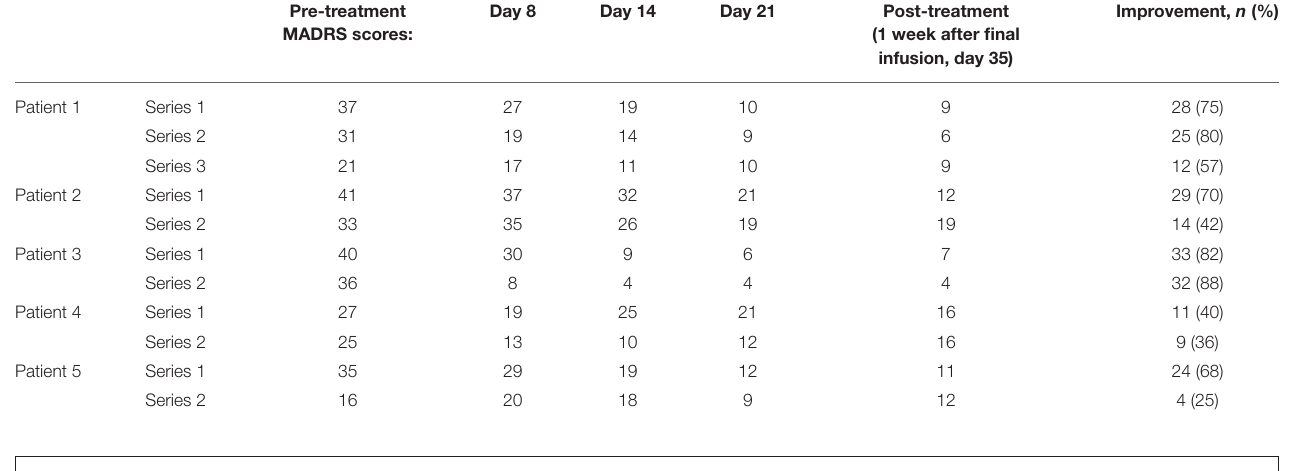
TABLE 1 | Depressive symptoms in the course of ketamine treatment.